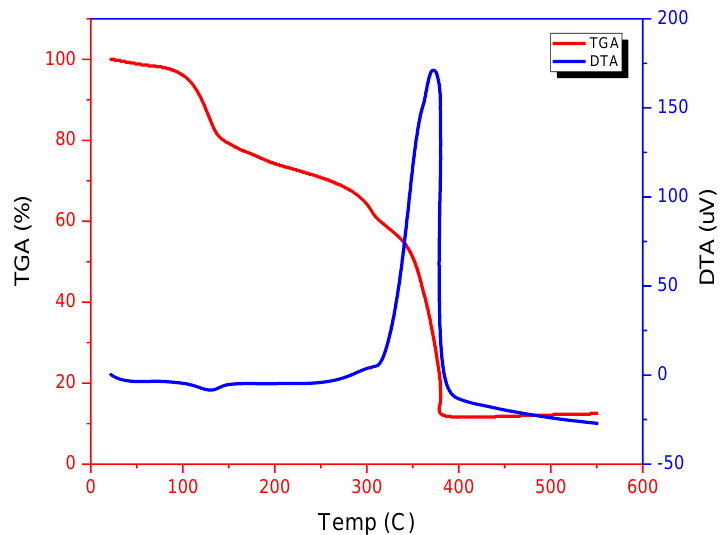
Figure 6. TGA and DTA thermograms of Pd(II) complex.